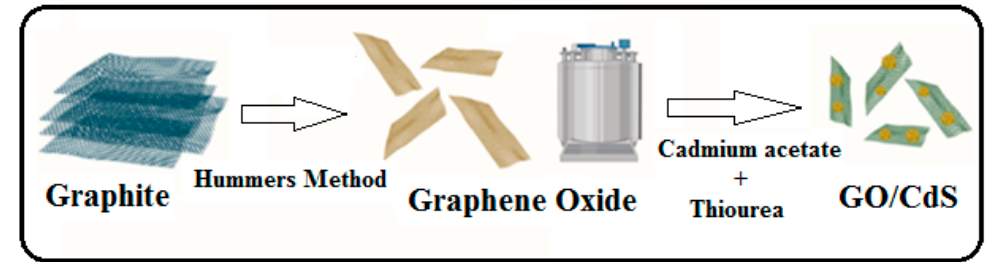
Figure 1. Schematic illustration of GO/CdS synthesis